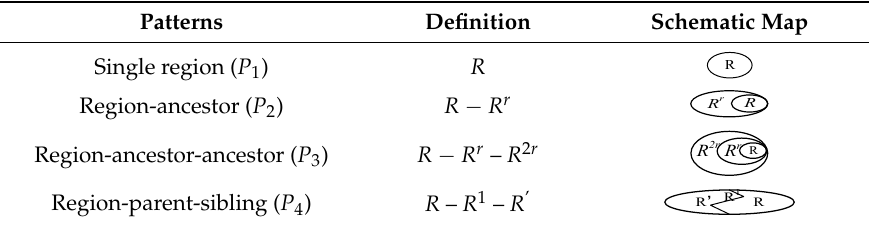
Table 1. The 4 co-occurrence patterns in CBPT.